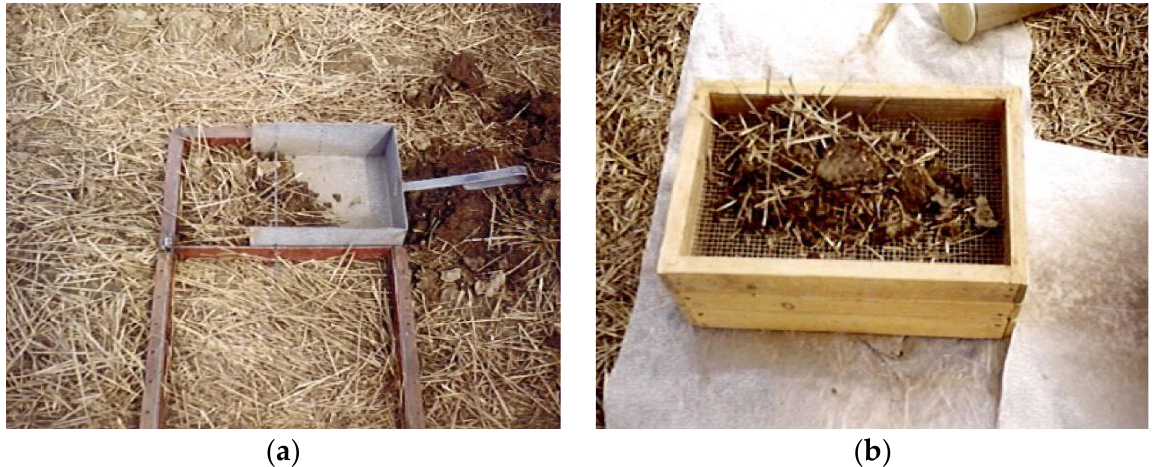
Figure 2. Dozing of soil layers ( a ); the estimation of soil aggregate fraction percentages ( b ). According to the Heinonen [28], “the seeds are placed directly on a firm and moist seedbed base to guarantee capillary transport of water to the seed (mainly from below as indicated by arrows directed towards the seed). The seed is covered by a layer of fine aggregates, at least 30 mm deep that protects from evaporation by acting as a barrier (indicated by the black bands) against upward movement of water evaporation